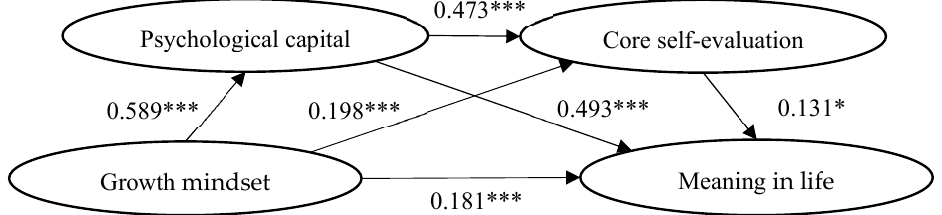
Figure 2. Roadmap of the influence of growth mindset on Meaning in Life. Note. * p < 0.05, *** p < 0.001.